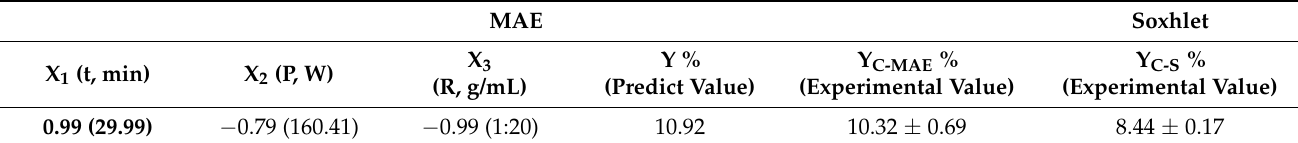
Table 3. The dimensionless and dimensional optimum points and the predicted and experimental extraction yield by microwave-assisted extraction (Y C-MAE ) and the extraction yield by the Soxhlet method (Y C-S ). The experimental extraction yields were mean ± standard deviation of three replications (n =